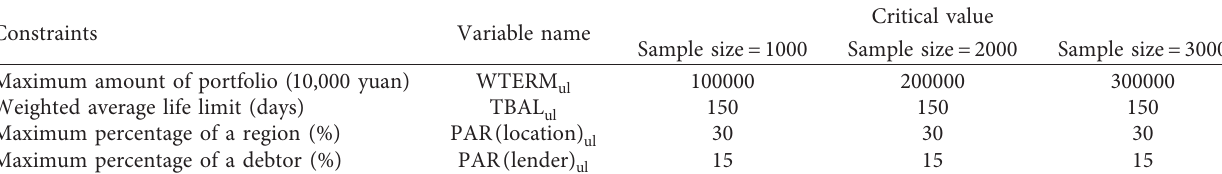
Table 1: Constraints and thresholds used in data validation.